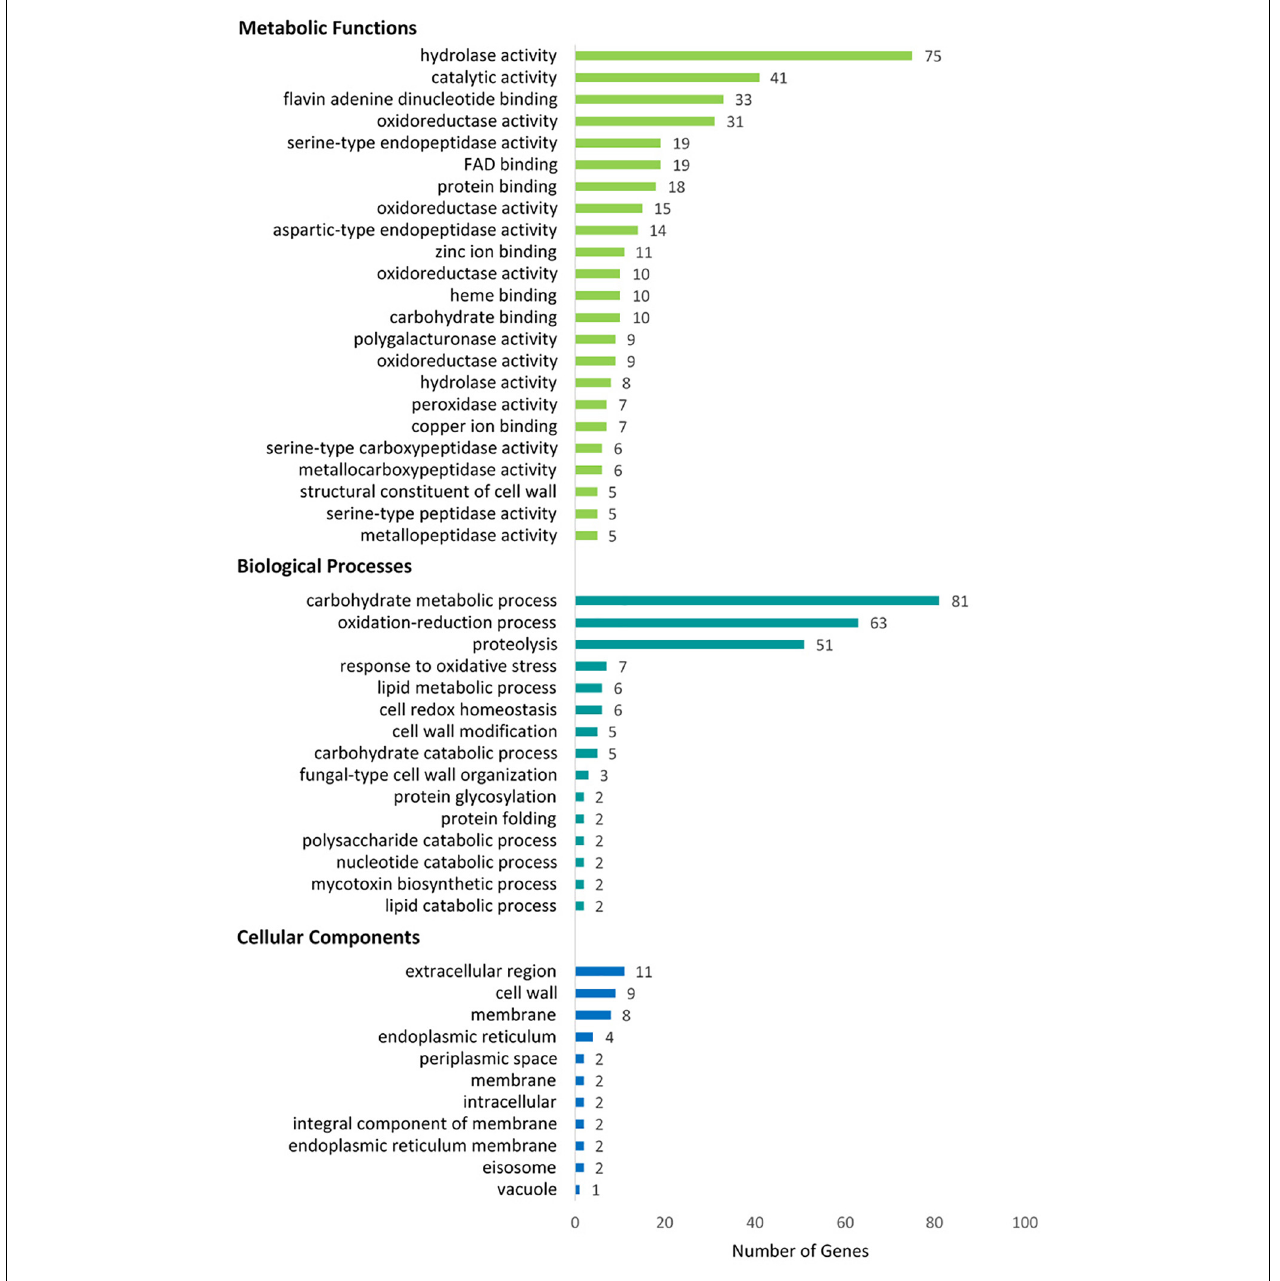
FIGURE 4 | Blast2Go classification of the putative N. psidii MA3 secretome proteins showing top categories associated with Metabolic Functions, Biological Process, and Cellular Component categories, respectively, (COGs).